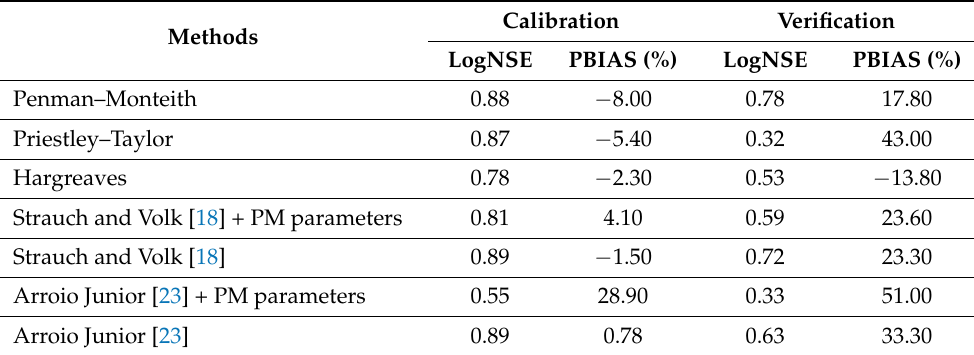
Table 3. Calibration and Verification Statistical Metrics for the simulated PM, PT and H methods and for the SV and AR modifications using the SWAT parameters obtained in the calibration for the PM method and for SV and AR